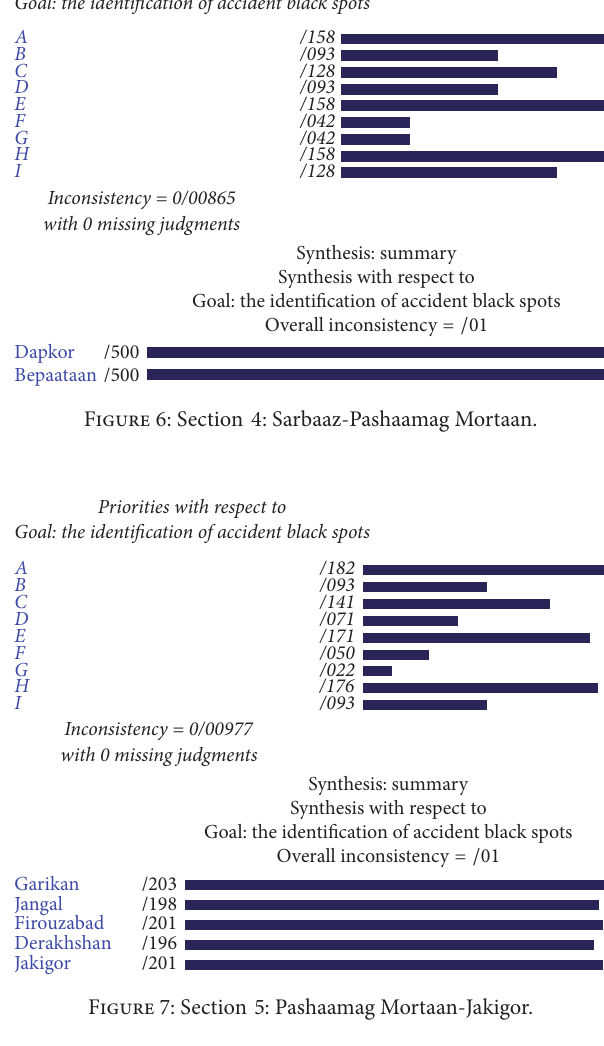
Table 9: AHP preference scale.